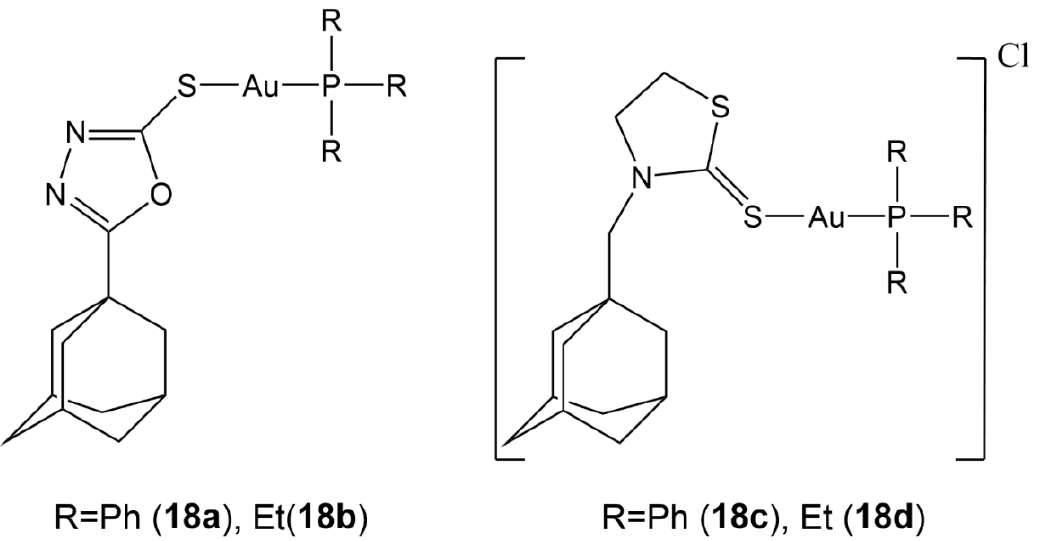
Figure 13. Gold(I) complexes with tertiary phosphine and 3-methyladamantane–1,3,4-oxadiazole-2-thione ( 18a , 18b ) and 5-adamantyl-1,3-thiazolidine-2-thione ( 18c , 18d ).